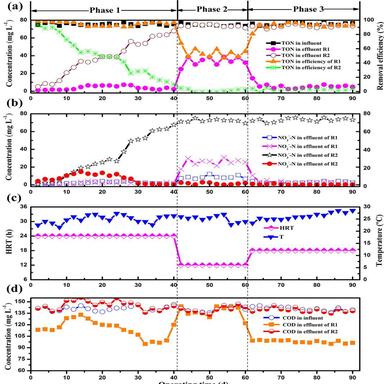
Long-term bioreactor performance over 90 days: variations of TON concentration and removal efficiency (a), the influent and effluent NO3 −-N, NO2 −-N concentrations (b), variations of HRT and temperatures of R1 and R2 (c), variations of COD concentration of R1 and R2 (d).